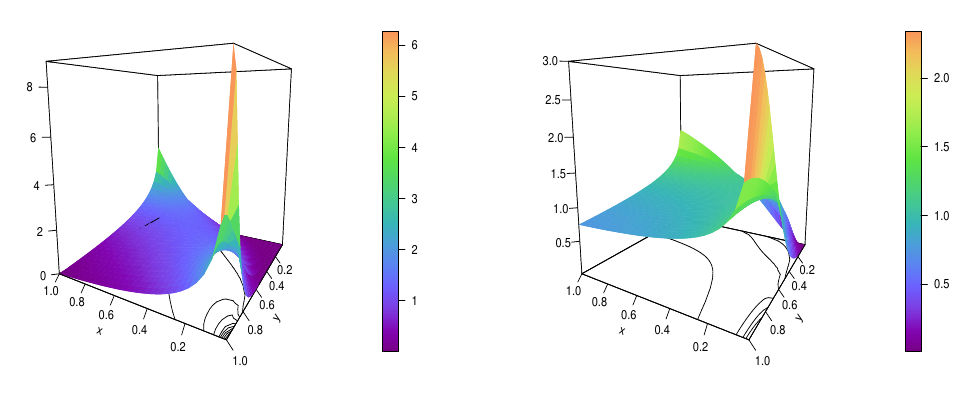
Figure 4. Plots of the IP copula density for α = 1/2 and β = 2 ( left ) and β = 1/2 ( right ).